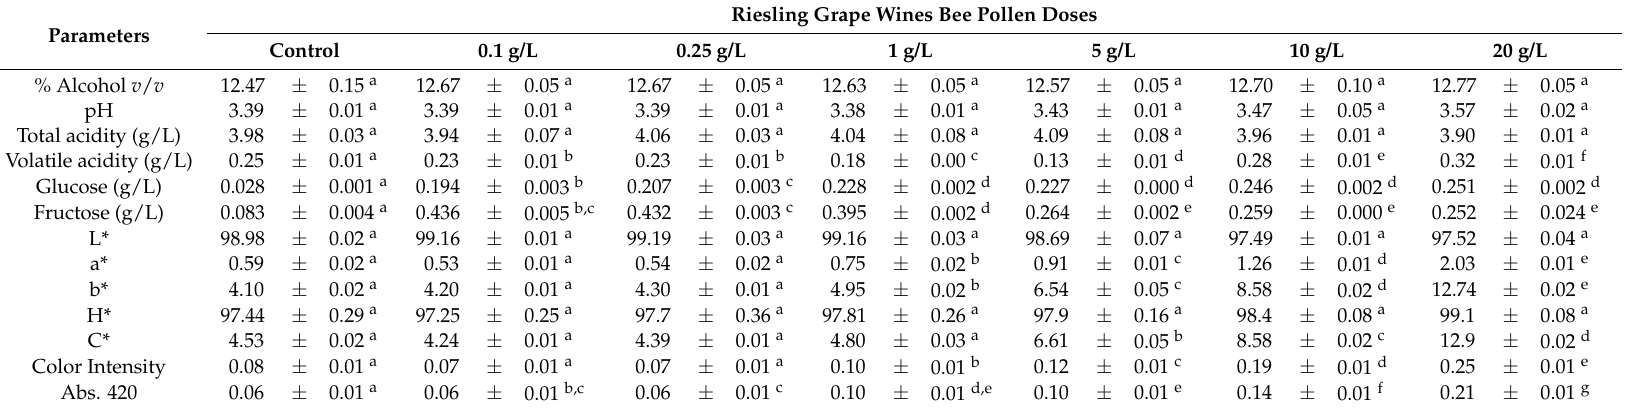
Table 4. Physico-chemical parameters of Riesling wines with bee pollen addition (0.1, 0.25, 1, 5, 10 and 20 g/L) and